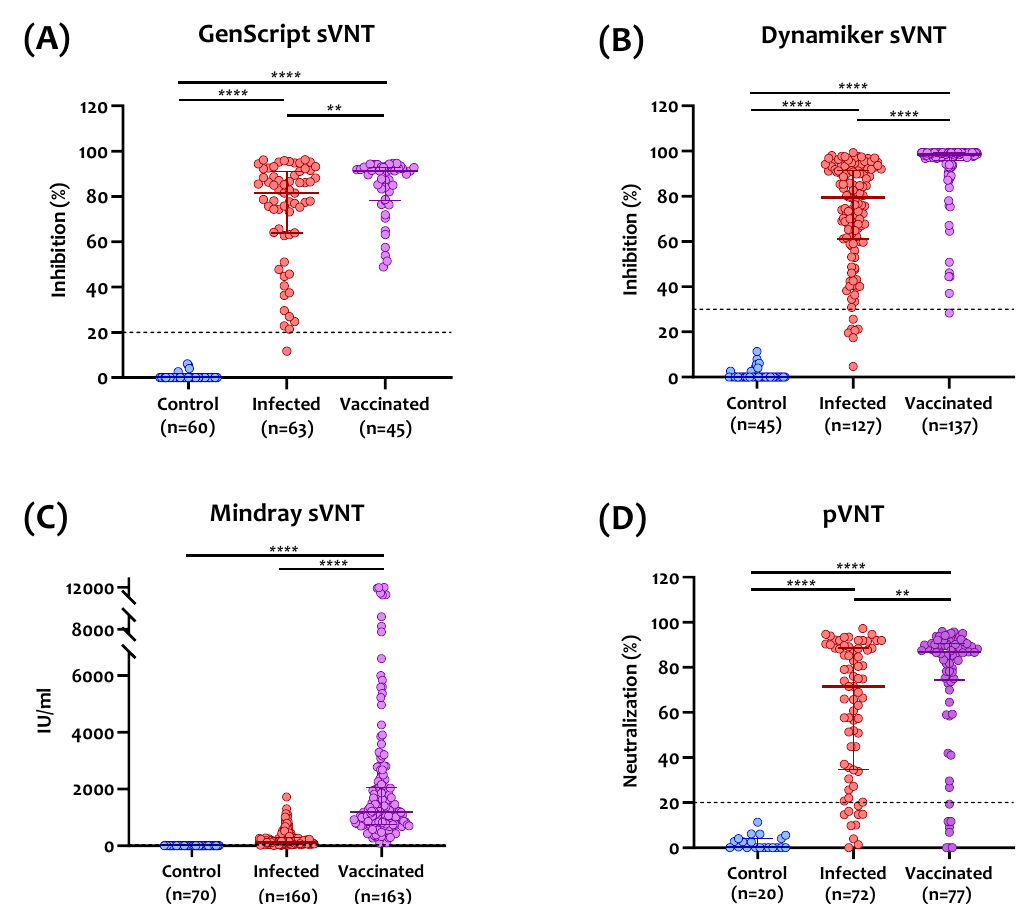
Figure 2. Dot plot of nAb results obtained from ( A ) GenScript SARS-CoV-2 surrogate virus neutralization test (sVNT), ( B ) Dynamiker sVNT, ( C ) Mindray NTAb sVNT, and ( D ) pseudovirus neutralization test (pVNT), using samples collected from healthy controls, SARS-CoV-2 infected patients, and COVID-19 vaccinated individuals. Individual points obtained, median values, and interquartile ranges (IQR) are shown. The dotted lines represent the cutoff at 30% inhibition for GenScript’s and Dynamiker’s sVNT, 33.1 IU/ml for Mindray’s sVNT, and 20% neutralization for pVNT. P values were calculated using one-way analysis of variance